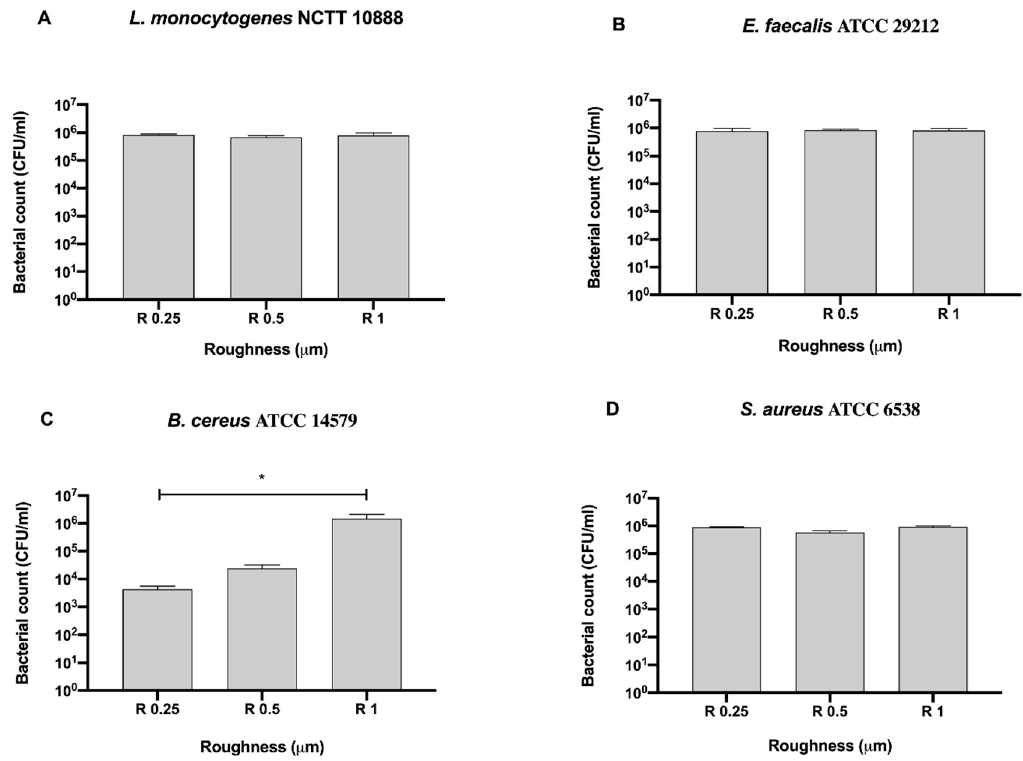
Figure 6. Antibacterial activity of di ff erent surface roughness against Gram-positive bacteria ( A ) L. monocytogenes NCTT 10888, ( B ) E. faecalis ATCC 29212, ( C ) B. cereus ATCC 14579 and ( D ) S. aureus ATCC 6538, * p < 0.05.